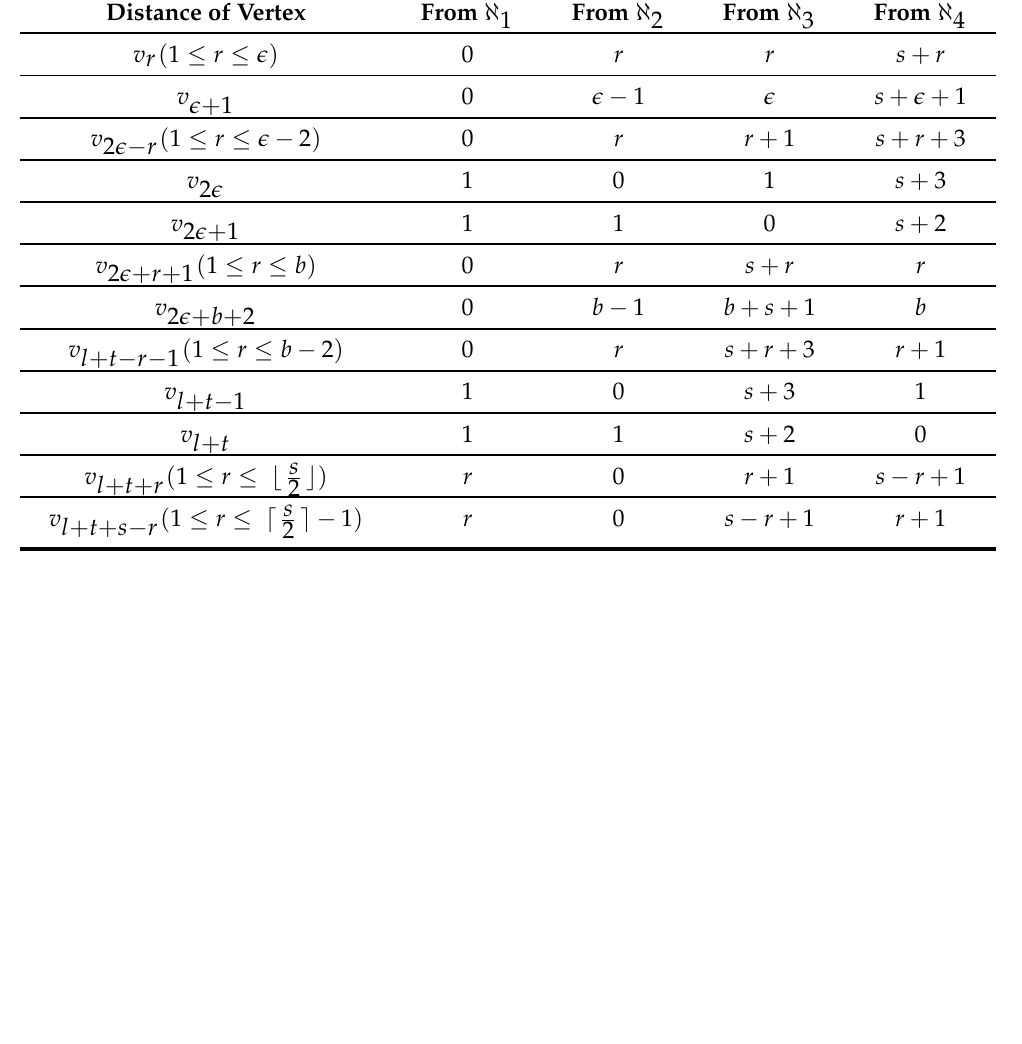
Table 4. Distance codes of V ( KP ( l , t , s )) with respect to ℵ for l = 2 (cid:101) + 1, where (cid:101) ≥ 2, and t = 2 b + 1, where b ≥ 2. Distance of Vertex From ℵ 1 From ℵ 2 From ℵ 3 From ℵ